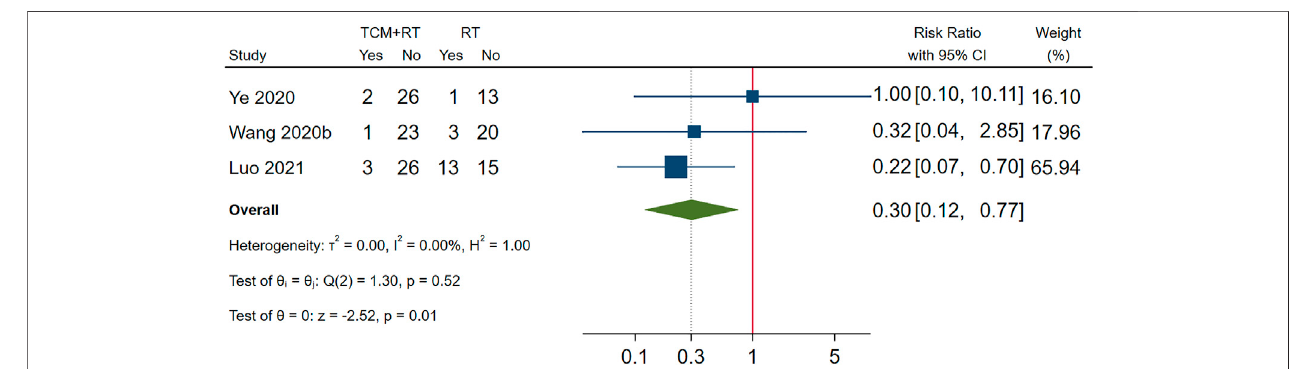
FIGURE 7 | Forest plot of mechanical